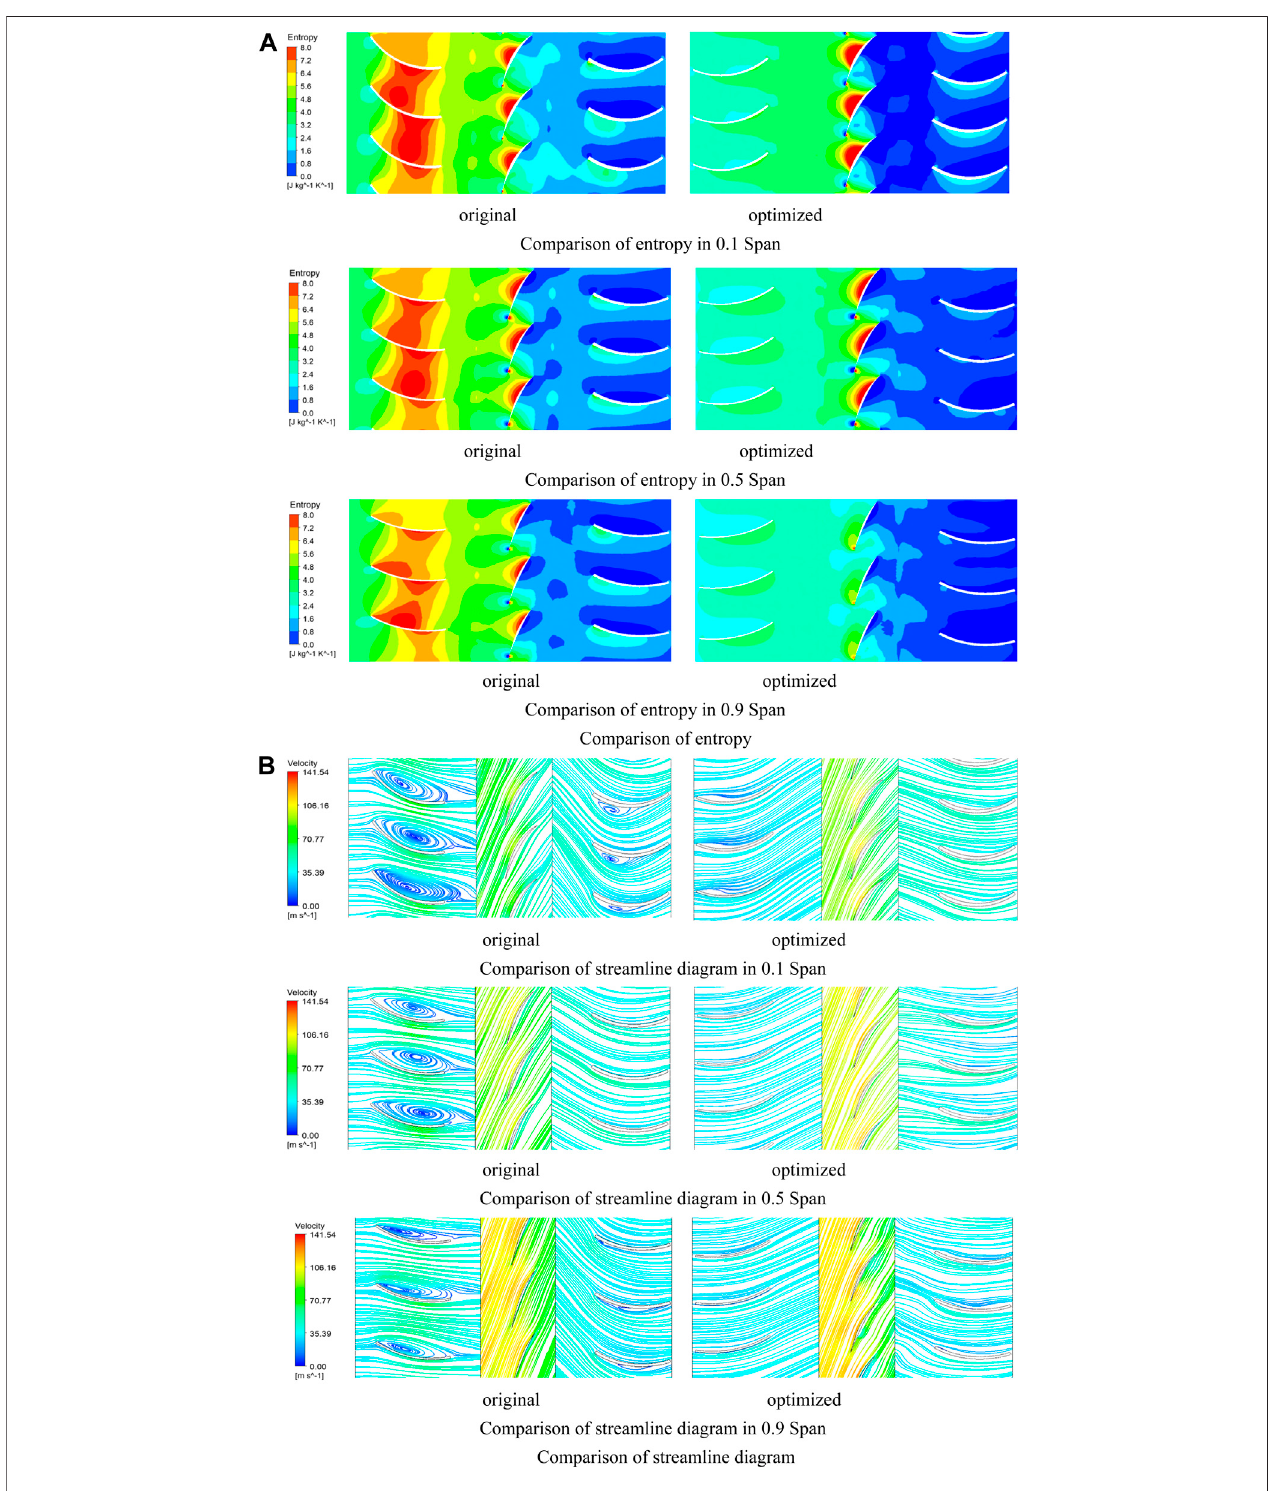
FIGURE 14 | Comparative analysis of fl ow fi eld results. Comparison of entropy in 0.1 Span comparison of entropy in 0.5 Span comparison of entropy in 0.9 Span (A) Comparison ofentropy.Comparison ofstreamlinediagramin0.1Span comparison ofstreamline diagramin0.5Span comparison ofstreamline diagramin0.9Span (B) Comparison of streamline diagram (C) Flow chart of moving blade entropy (D) Comparison Q =900000s − 2 isosurface of axail fan blade surface.